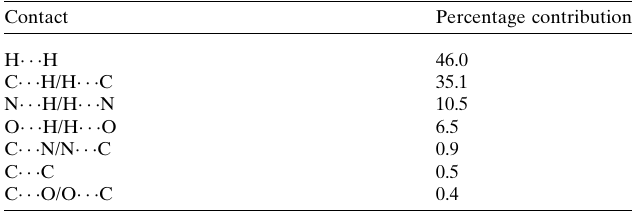
Table 2 Summary of short interatomic contacts (A˚ ) in the title compound. Contact